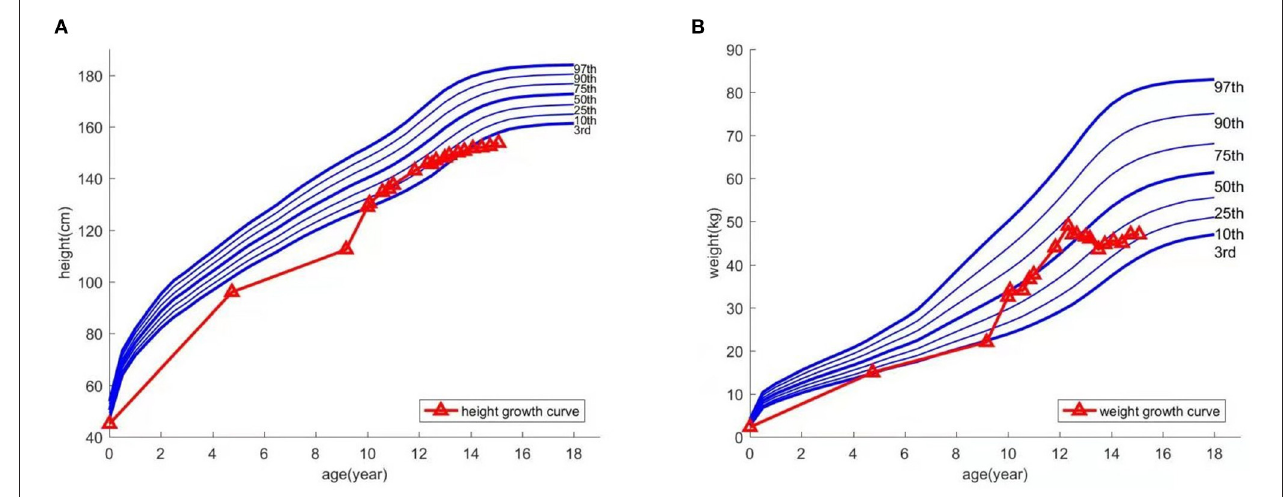
FIGURE 1 | Growth curve of height (A) and weight (B) .